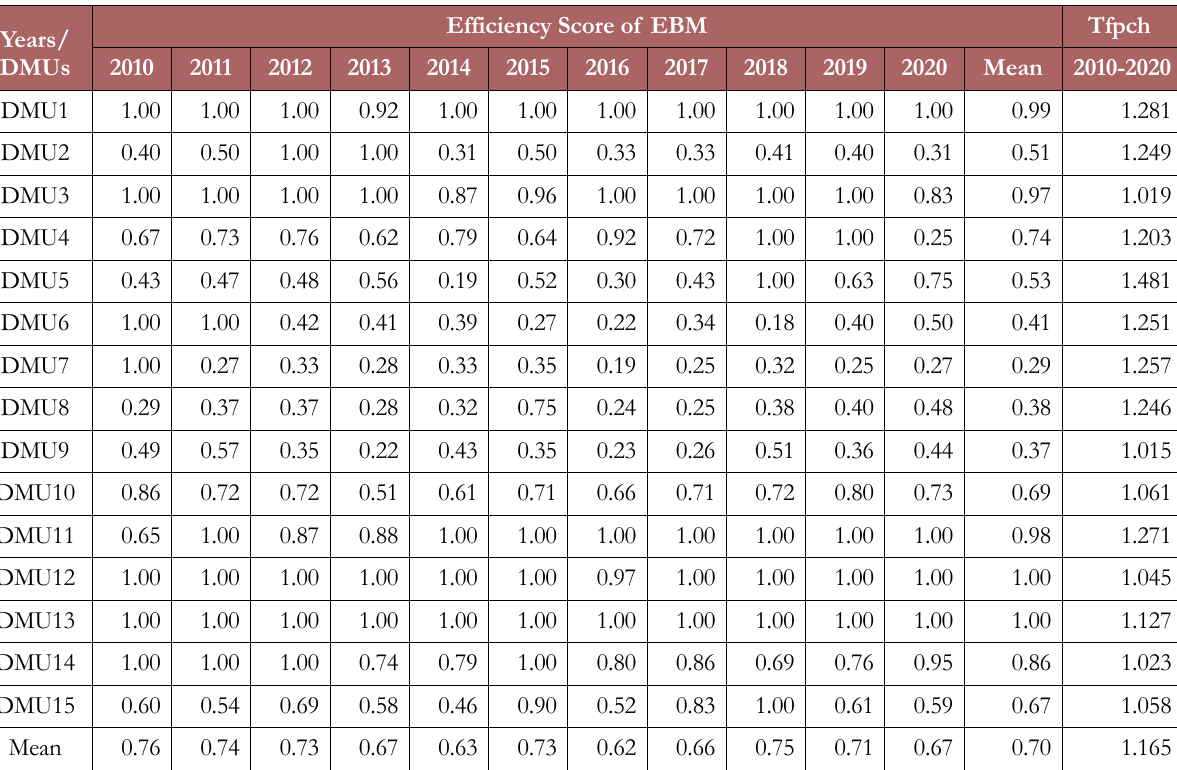
Table 6. Efficiency score and productivity index